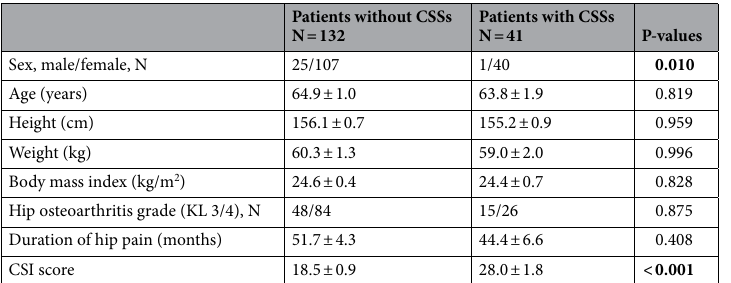
Table 2. Demographic and clinical factors. The results are expressed as the mean ± standard error of the mean, unless otherwise indicated. Statistically significant P-values (< 0.05) are indicated in bold. CSS central sensitivity syndrome, KL Kellgren–Lawrence, CSI central sensitization inventory.